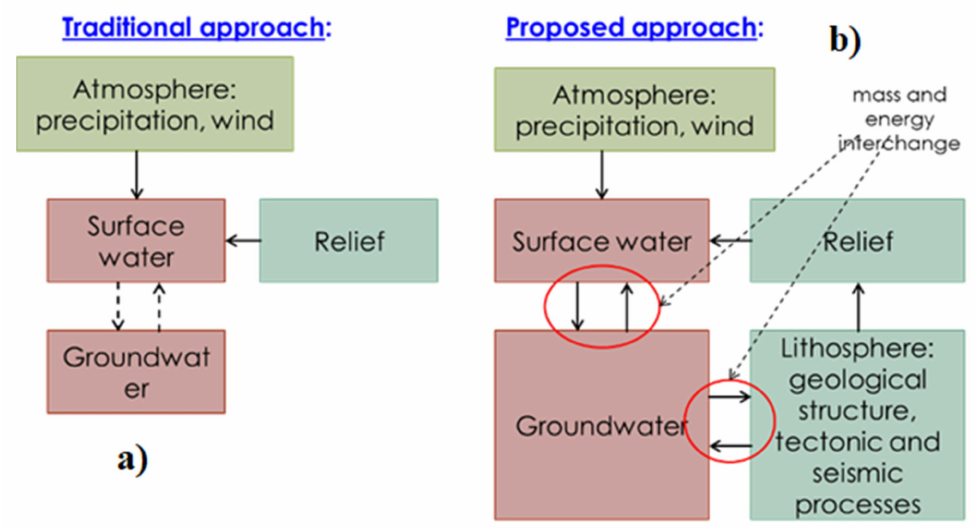
Figure 5. The key parts of a river basin system’s functions: ( a ) traditional view; ( b ) our pro- posed model.